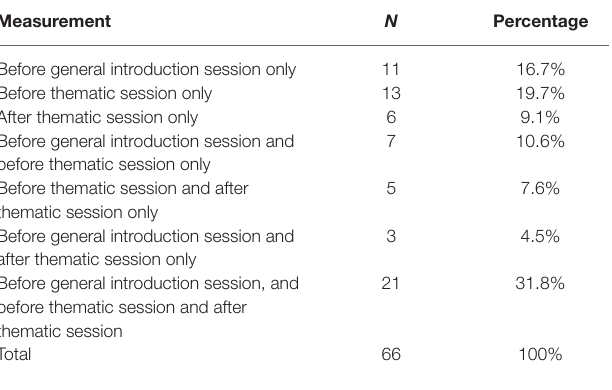
TABLE 1 | Number of respondents who completed the questionnaire.